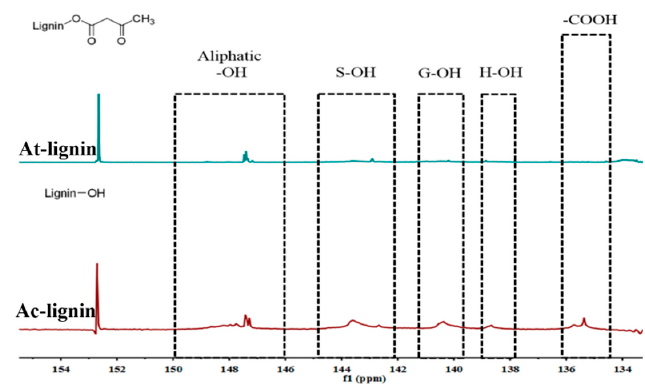
Figure 4. The 31 P NMR spectra of Ac-lignin and At-lignin.